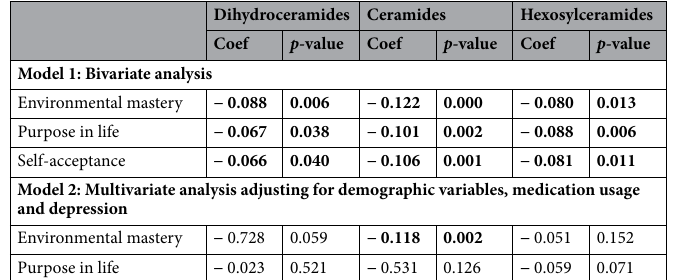
Dihydroceramides